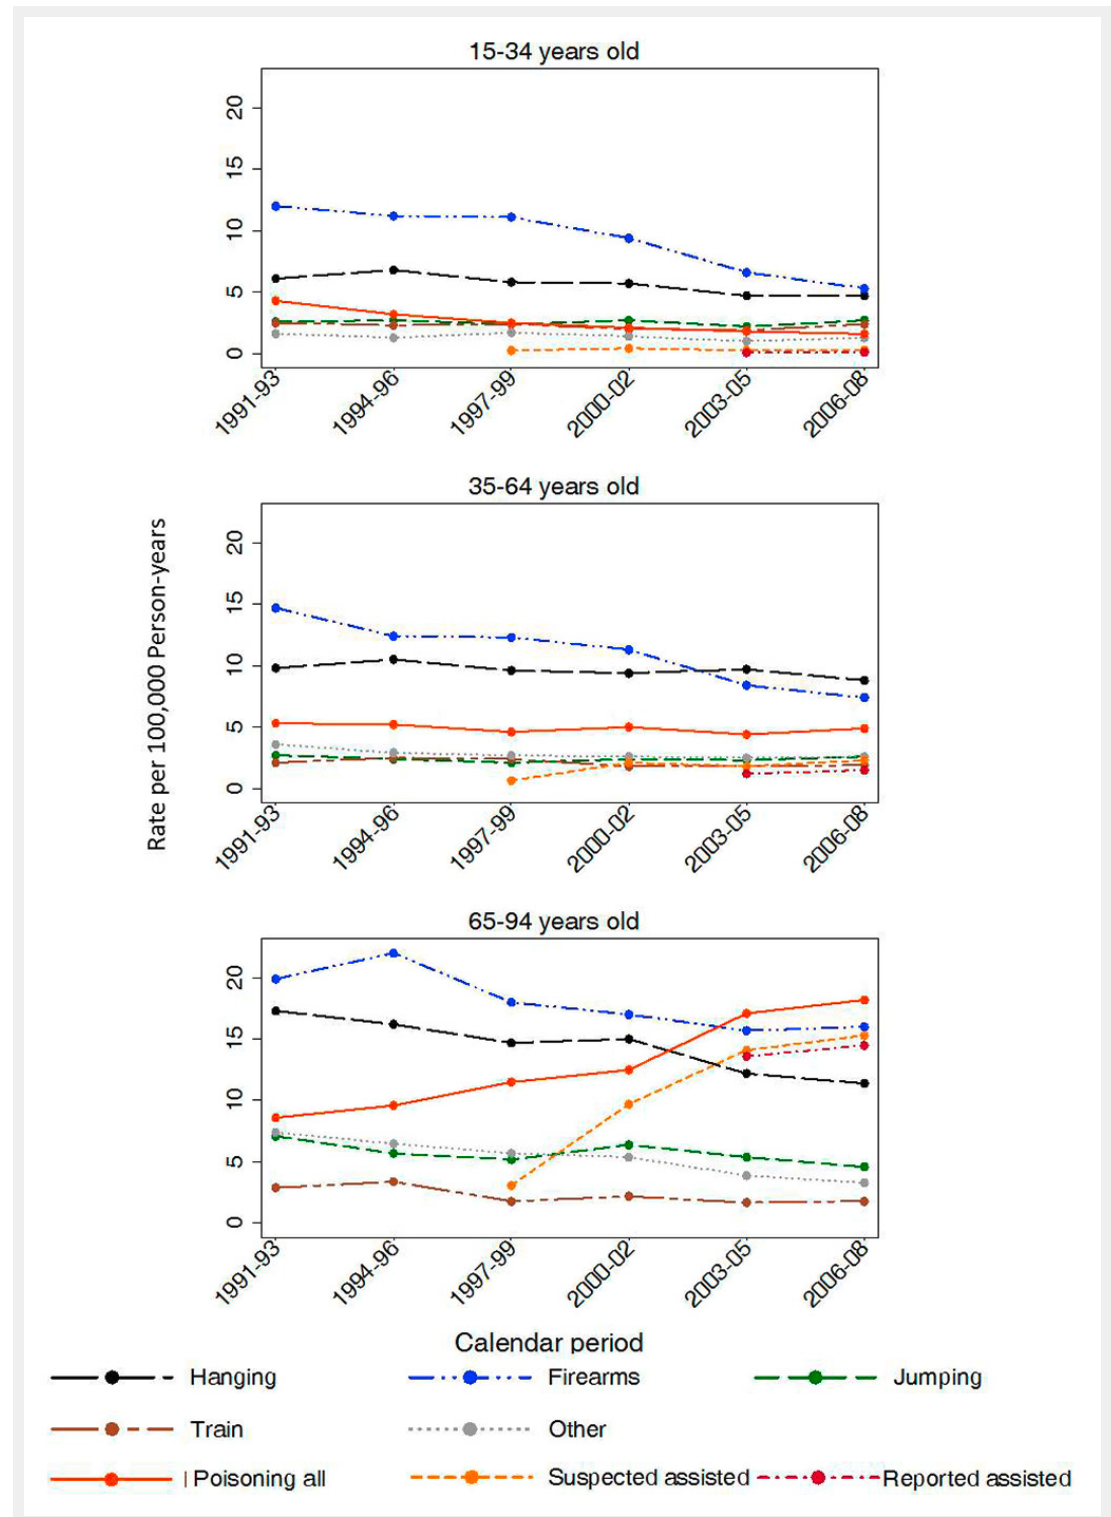
Figure 2 Time-trends of suicide rates by method in men; Switzerland